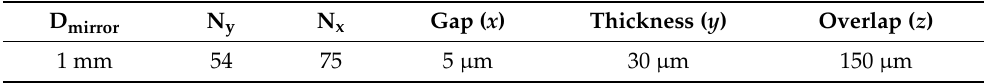
Table 1. Mirror and combdrive